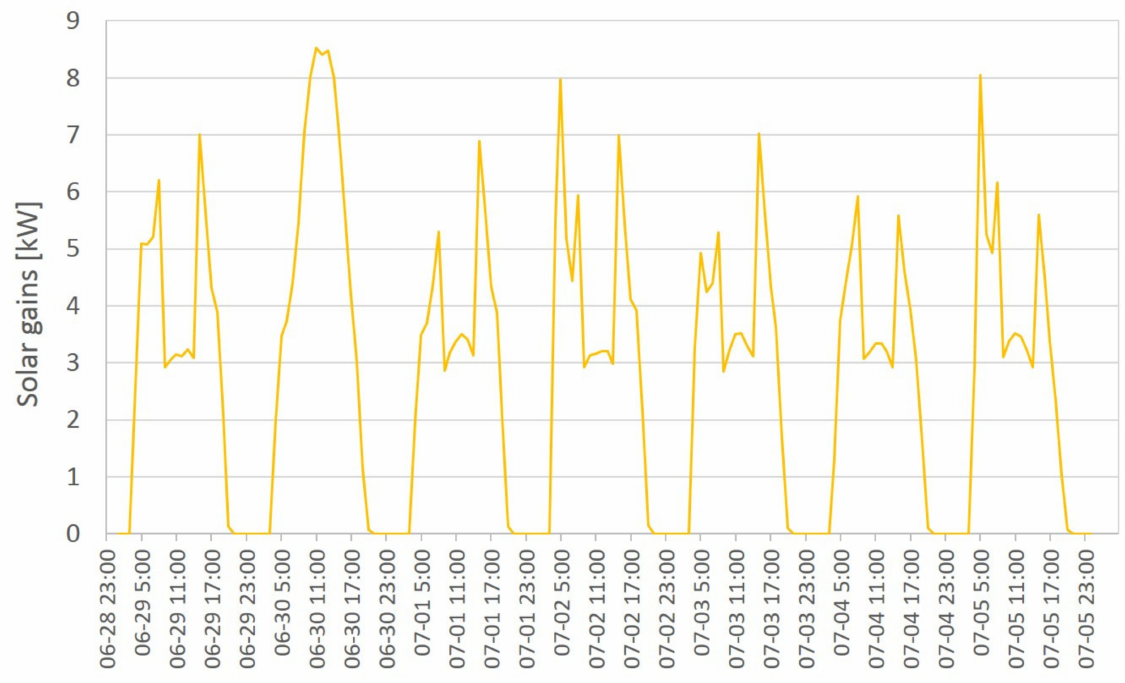
Figure 11. Distribution of solar gains for the selected week (without taking into account heat gains from